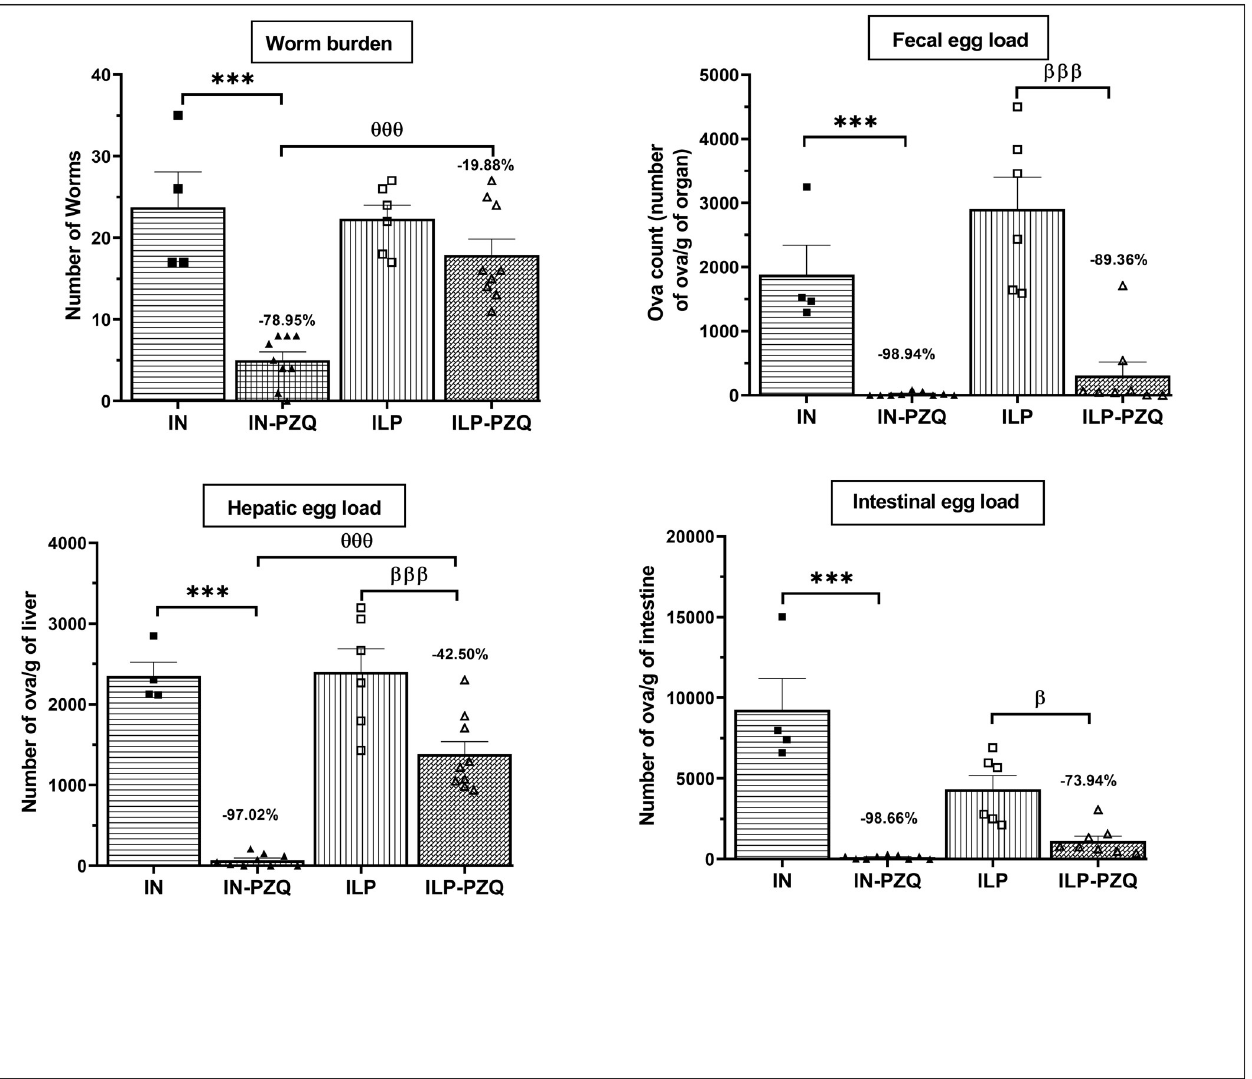
Fig 3. Effects of praziquantel treatment on the worm and egg burdens of Schistosoma mansoni -infected mice receiving a low-protein diet. Data are expressed as mean ± SEM (n = 4–9). Group HN: healthy mice receiving a standard diet; group IN: infected-untreated mice receiving a standard diet; group IN-PZQ: infected mice receiving a standard diet and treated with praziquantel; group HLP: healthy mice receiving a low-protein diet; group ILP: infected- untreated mice receiving a low-protein diet; group ILP-PZQ: infected mice receiving a low-protein diet and treated with praziquantel. ANOVA followed by Turkey multiple comparison test. ��� P < 0.001: values are significantly different from the infected-untreated mice receiving a standard diet (group IN). β P < 0.05; βββ P < 0.001: values are significantly different from infected-untreated mice receiving a low-protein diet (group ILP). θθθ P < 0.001: values significantly different from infected mice receiving a standard diet and treated with praziquantel at 100 mg/kg for 5 consecutive days (group IN-PZQ). The number on top of each bar graph represents the percentage of variation.